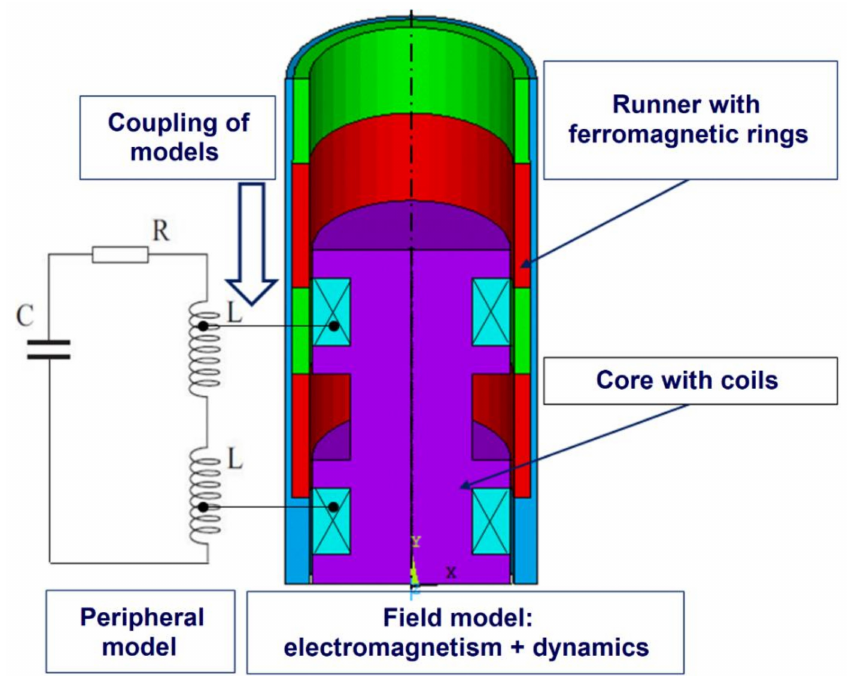
Figure 9. Components of the numerical